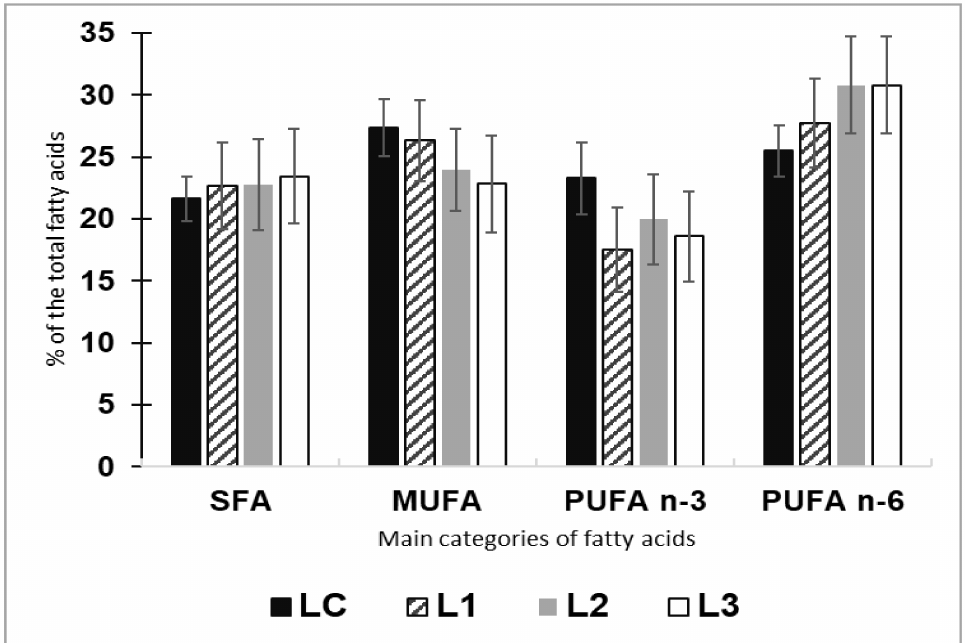
Figure 1. Categories of fatty acids (SFA: saturated fatty acids, MUFA: monounsaturated fatty